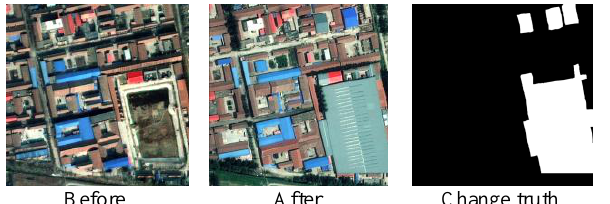
Figure 3. High resolution remote sensing images and the ground truth of land cover changes.